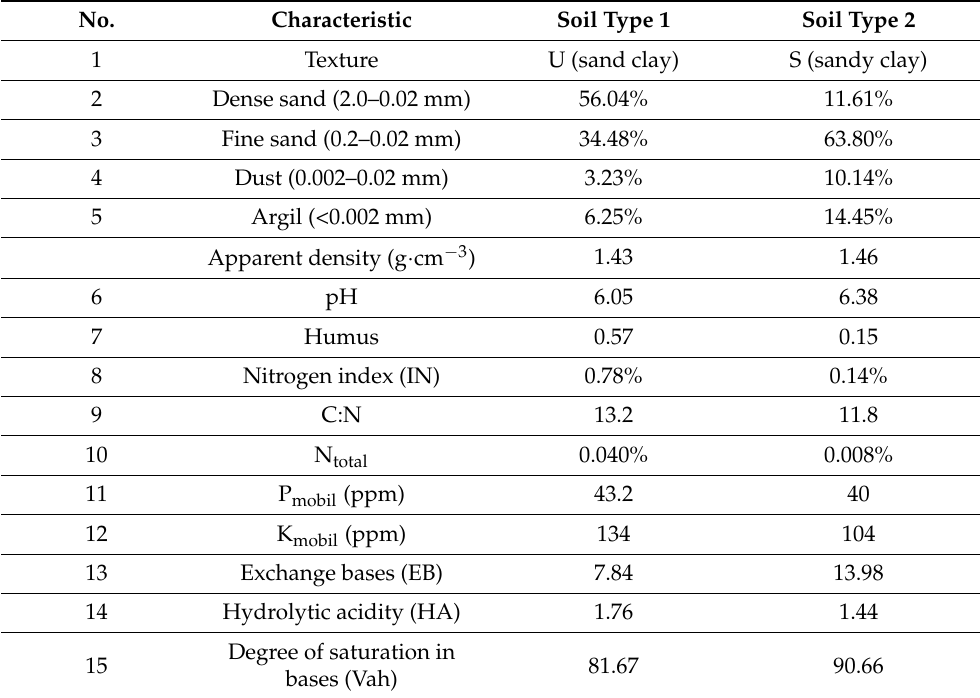
Table 3. Characteristics of the analyzed soils.